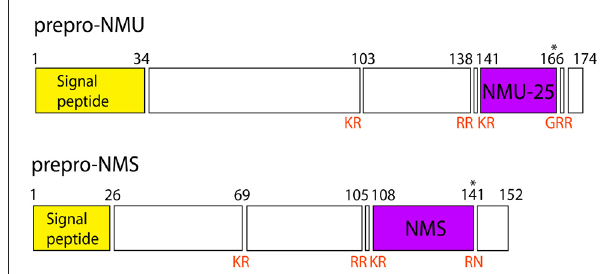
FIGURE 3 | Schematic structure of prepro-NMU and prepro-NMS in humans. Data from Protein Knowledgebase (UniProtKB) P48645 and Q5H8A3, respectively. Schematic structure of prepro-NMU is modified from Austin et al. (1995). Numbers refer to residues and cleavage sites are given in red. Asterisk marks amidated